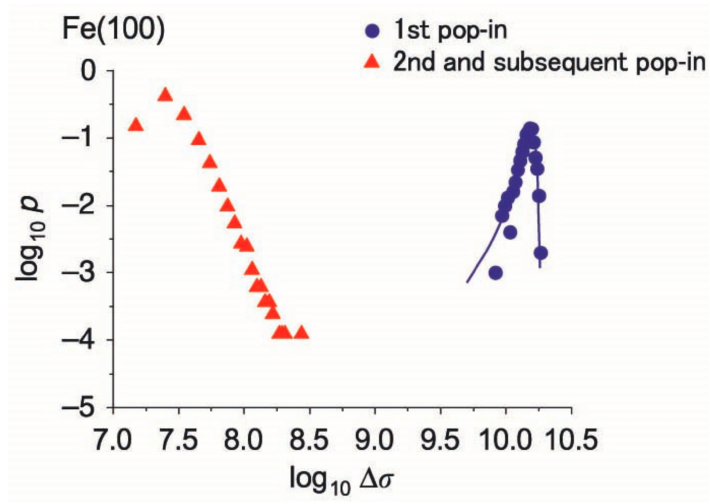
Figure 17. Probability distribution of pop-in magnitude in bcc Fe